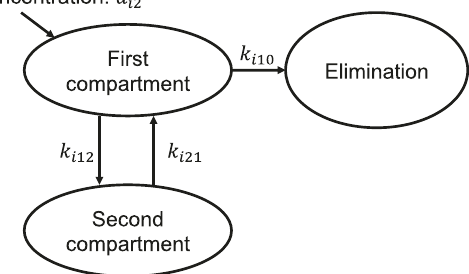
Fig. 5 Diagram of the fi nally fi tted two-compartment model.